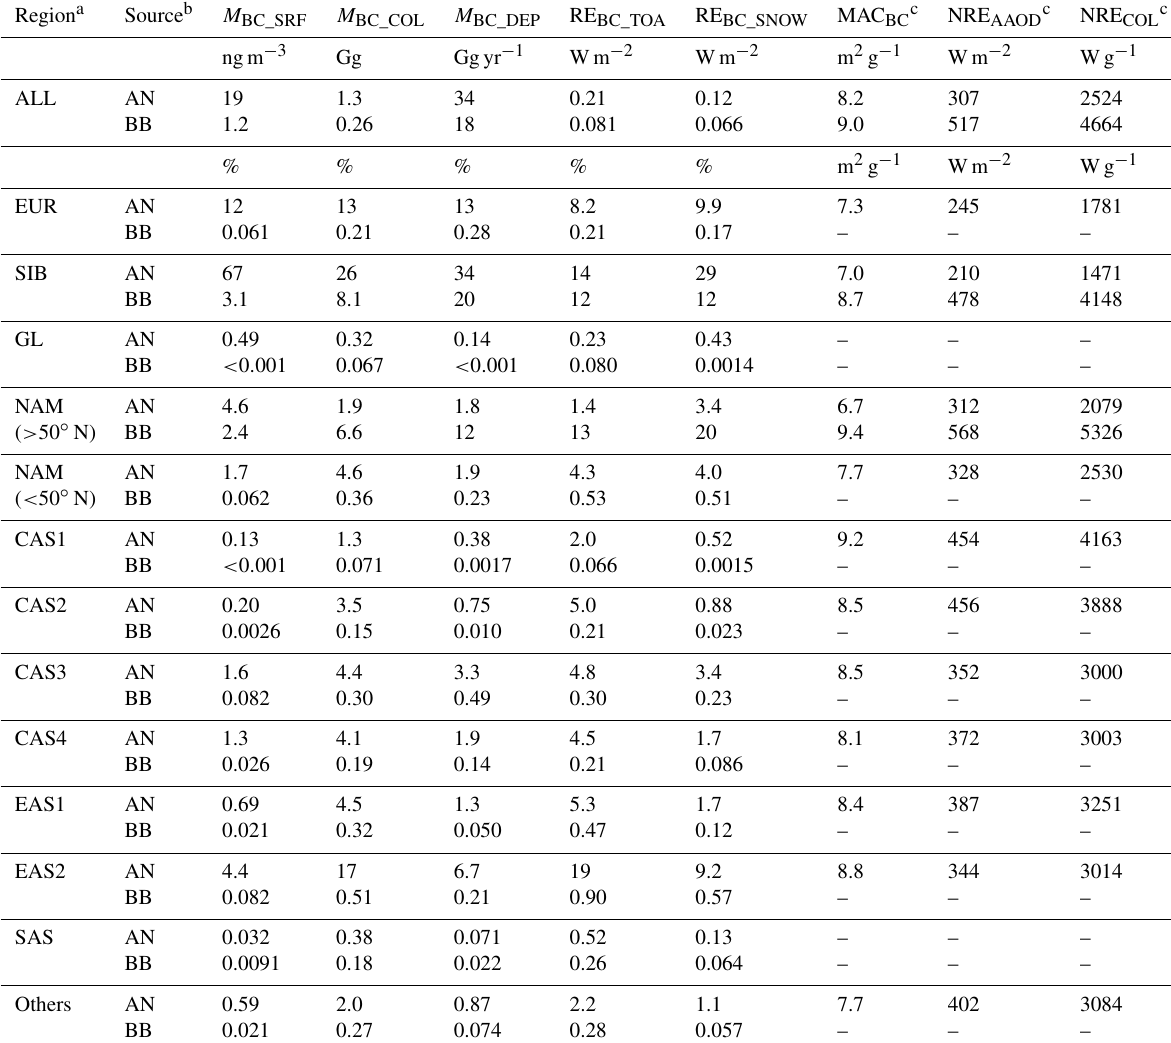
Table 2. Simulated BC statistics in the Arctic ( > 70 ◦ N). Region